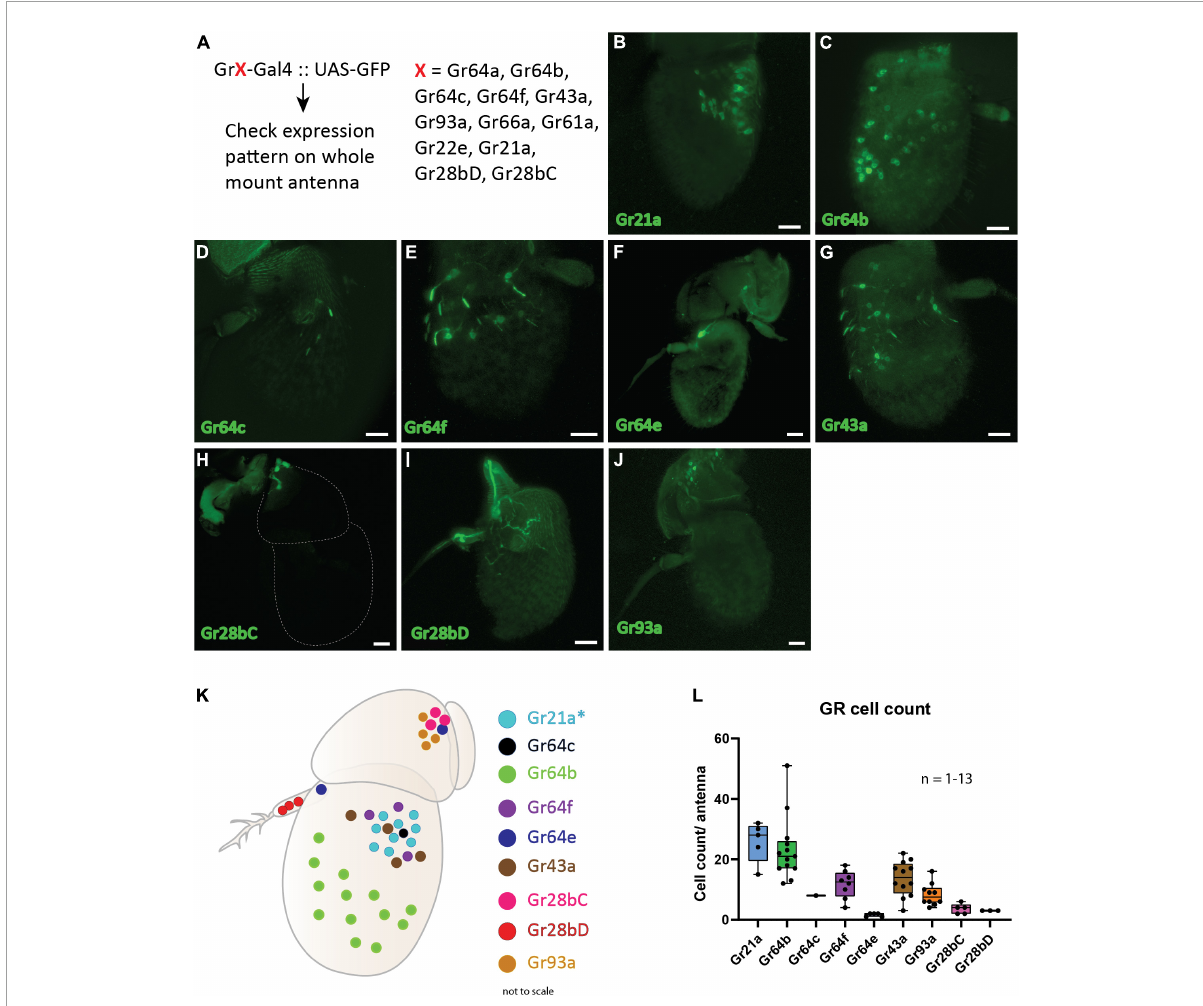
FIGURE1 Spatial expression map of gustatory receptors expressed on D. melanogaster antenna. (A) Schematic diagram of methodology where the Gal4-UAS binary expression system was used to check expression of 12 GRs. (B–J) Expression patterns of individual gustatory receptors on the antenna with GFP. Scale bars = 20 µ m. (K) Schematic representation of the spatial expression pattern of nine GRs on the antenna. Asterisk (*) denotes that the regions expressing Gr21a also co-express Gr63a in the same neuron and Gr10a in the neighboring neuron housed in the same sensilla. (L) Cell counts of individual GR-Gal4 positive cells across multiple replicates observed positive for GFP